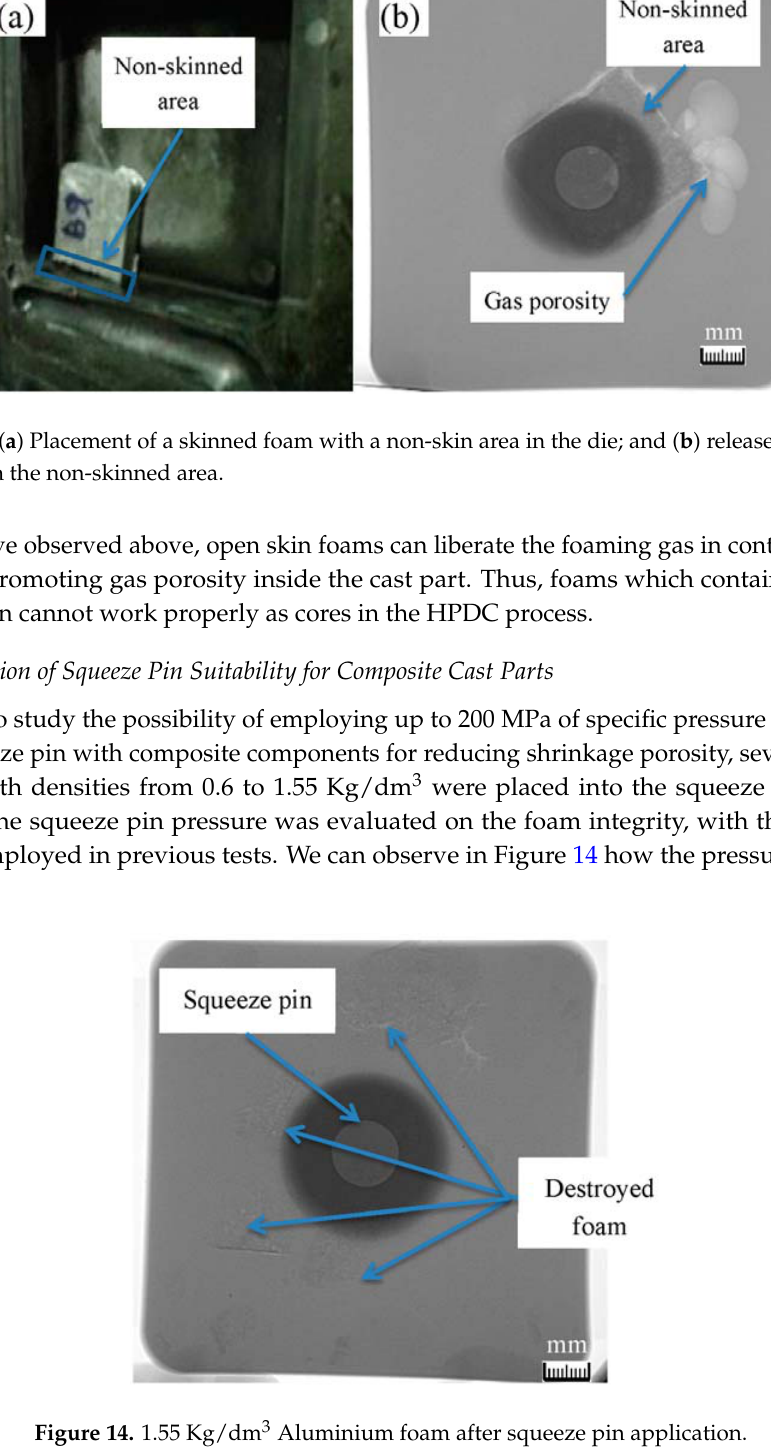
Figure 15. Horizontal placement to the metal flow of the core . The impact of the metal flow with the foam core causes a shear rupture of the core foam. It is necessary to select the positioning of the core in the die or the metal flows over the core by re ‐ designing the runners in order to decrease the direct impact of injected metal on the core.